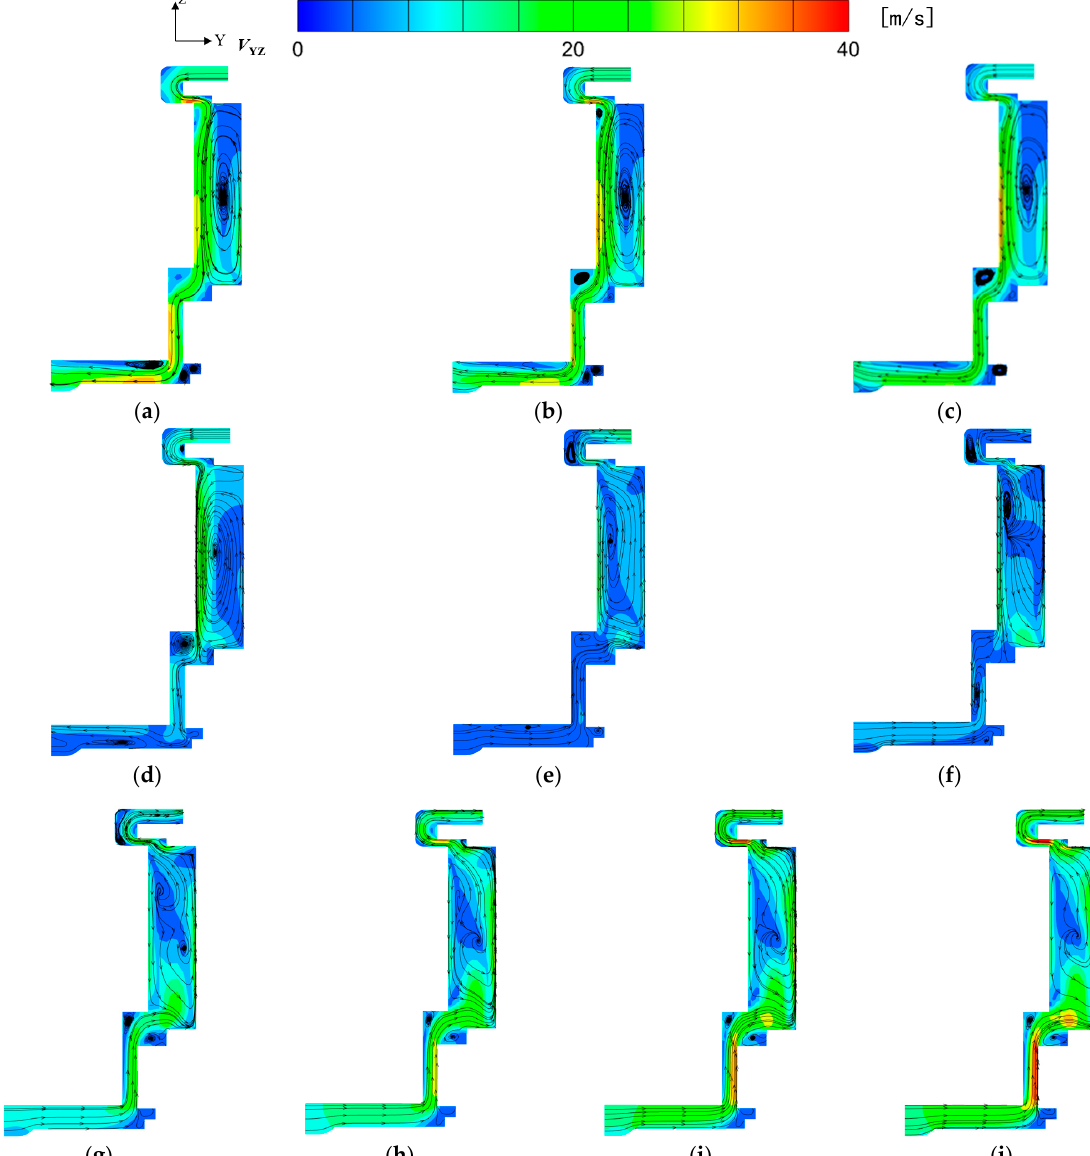
Figure 12. Velocity distribution of the first-stage liquid-sealing impeller at different rotating speeds: ( a ) 8000 rpm; ( b ) 9000 rpm; ( c ) 10,000 rpm; ( d ) 11,000 rpm; ( e ) 12,000 rpm; ( f ) 13,000 rpm; ( g ) 14,000 rpm; ( h ) 15,000 rpm; ( i ) 16,000 rpm and ( j ) 17,000 rpm.